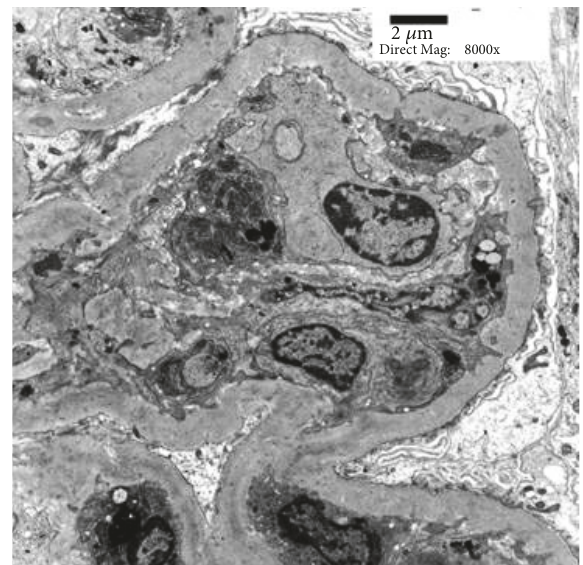
Figure 7: There are endocapillary cell hypercellularity and several small electron dense deposits within the glomerular basement membrane (electron microscopy, x